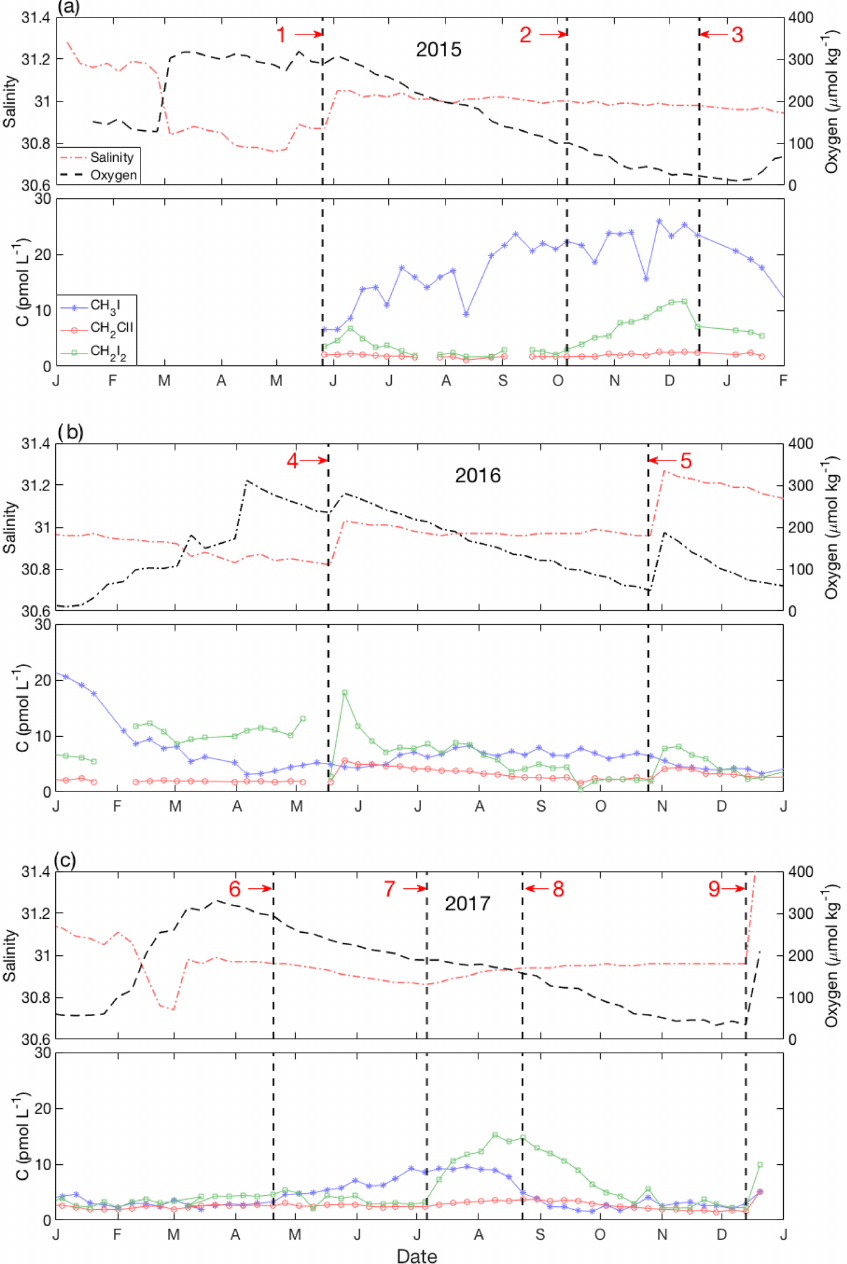
Figure 9. Detailed time series from near-bottom waters in (a) 2015, (b) 2016 and (c) 2017. For each year, panel (a) shows the variability of salinity (red dash-dot line) and dissolved oxygen (black dashed line); panel (b) shows iodocarbons (CH 3 I: blue stars; CH 2 ClI: red open circles; CH 2 I 2 : green open squares). The vertical bold dashed lines (1 to 9) represent the special events discussed in Sect.